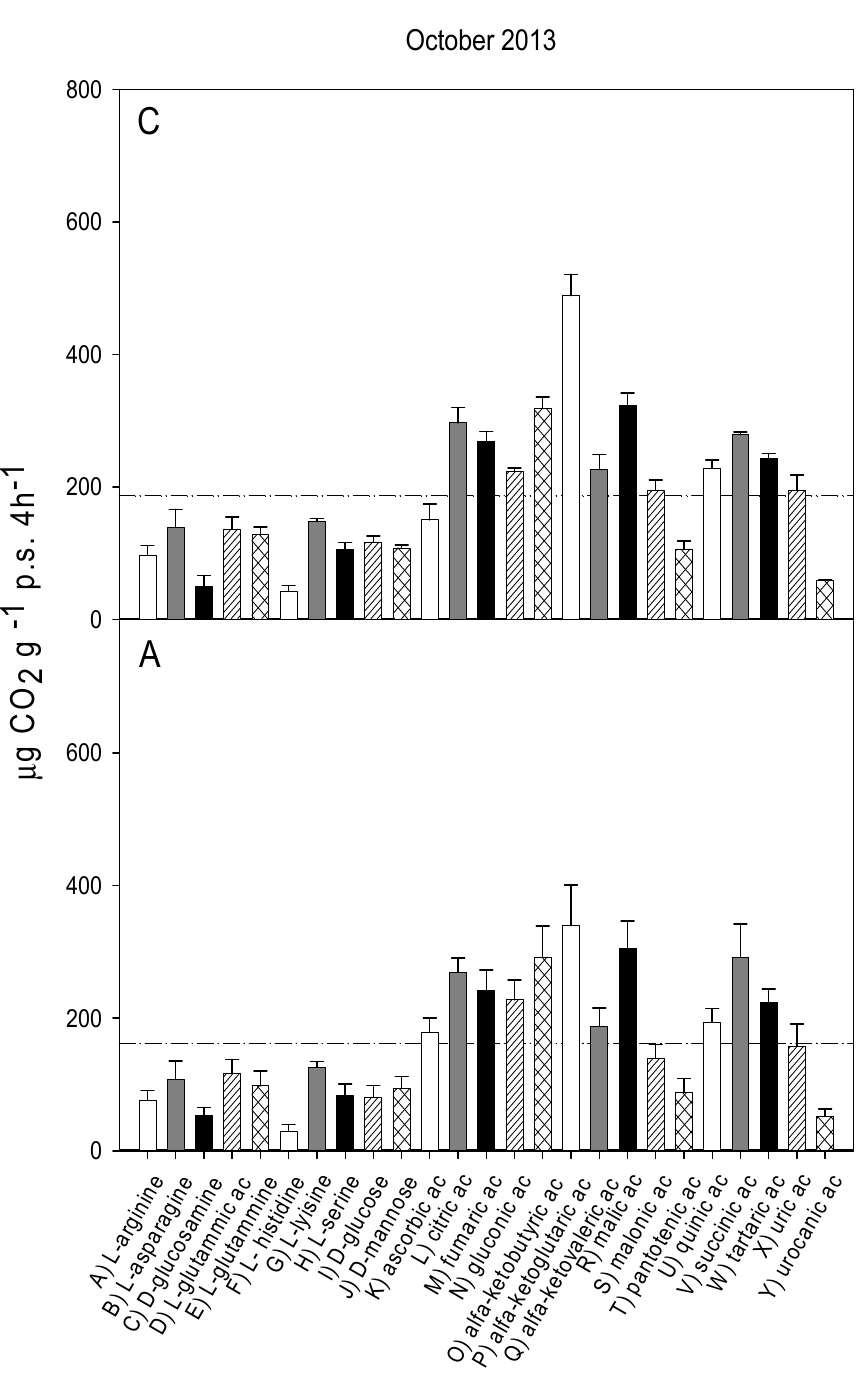
Figure 2. Catabolic response profile of chestnut ( C ) and agricultural ( A ) soils in October 2013. The dotted line represents the average substrate-induced respiration (ASIR), corresponding to 187 ± 7.9 in chestnut and to 162 ± 13.8 in agricultural soil (the values were not significantly different).